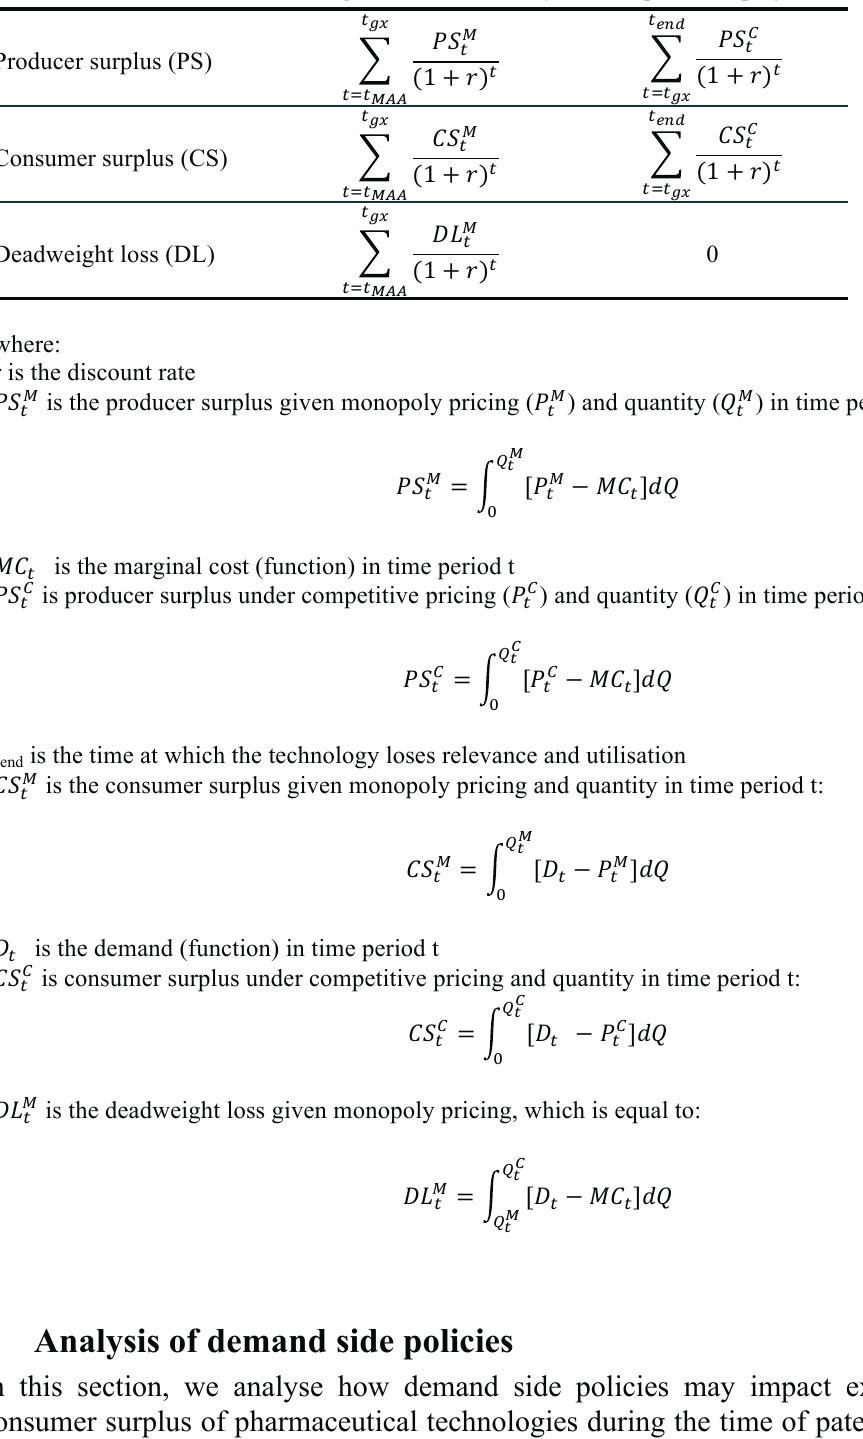
Table 1: Producer and consumer surplus during and post the end of market exclusivity. During market exclusivity Post patent